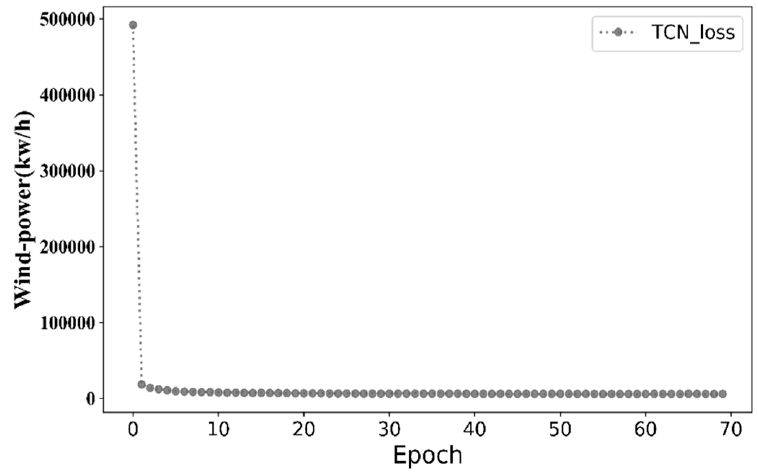
Figure 9. Convergence error training of the TCN model.